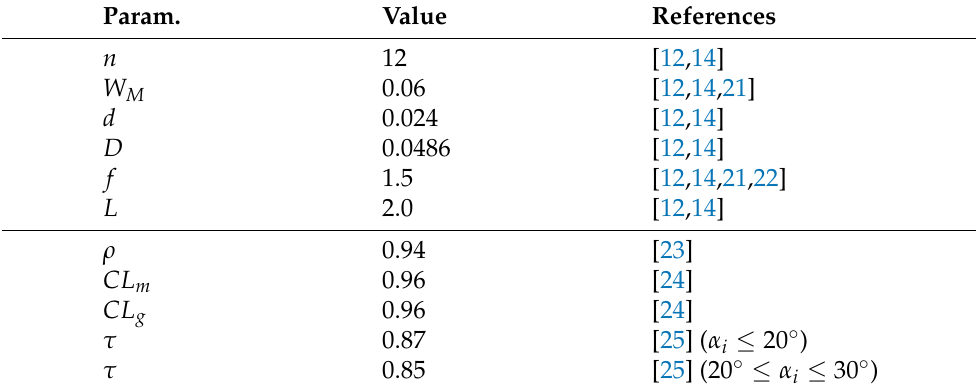
Table 1. Constant parameters in the study.